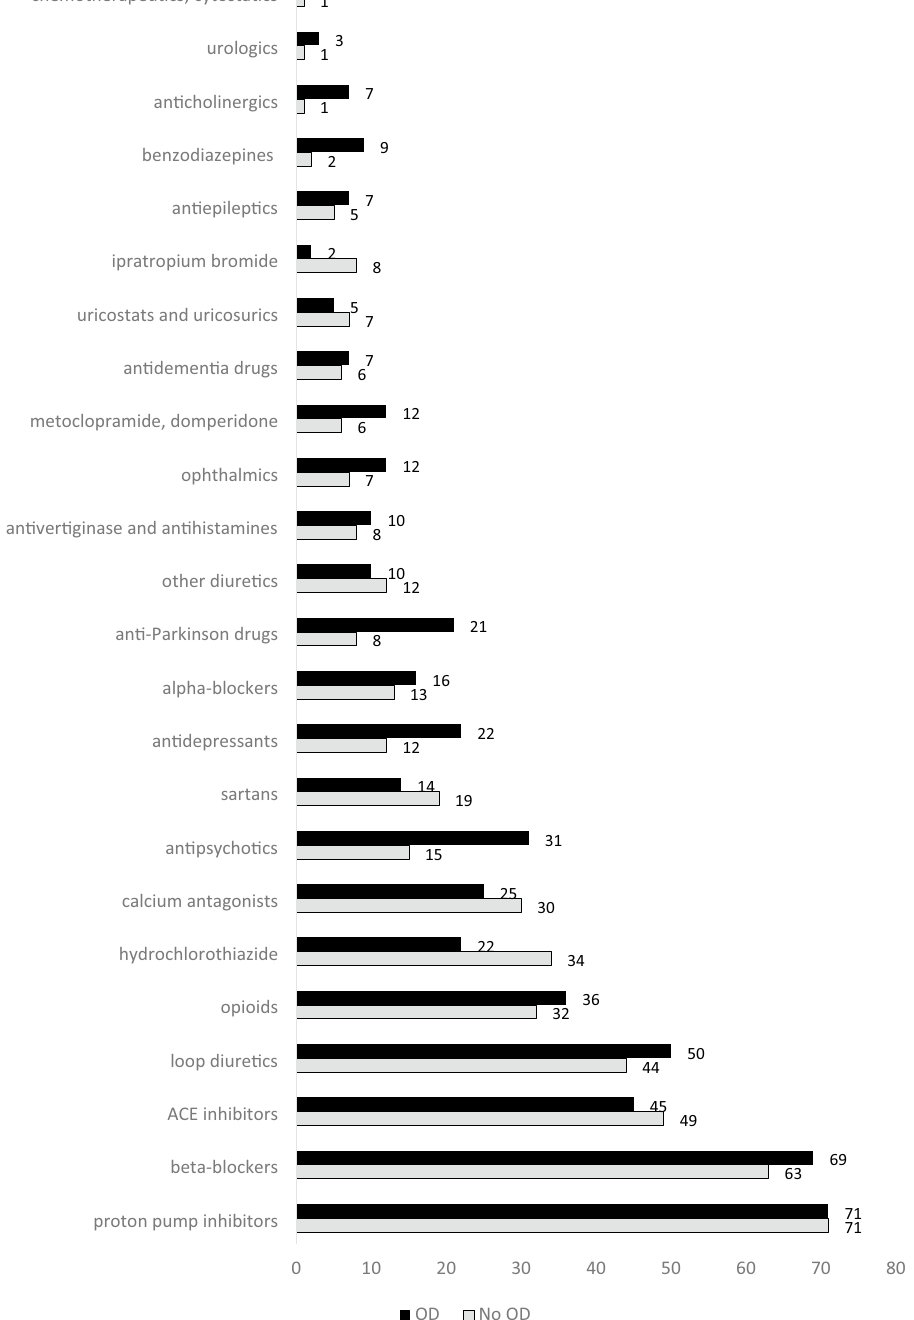
Figure 5. Prevalence of drug groups (%) comparing patients with and without